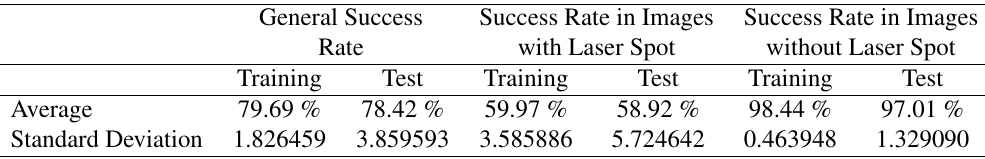
Table 8. TM+ FRBS WM − tunedGA results on models obtained with ZMNCC fixed to 0.55 by applying a genetic